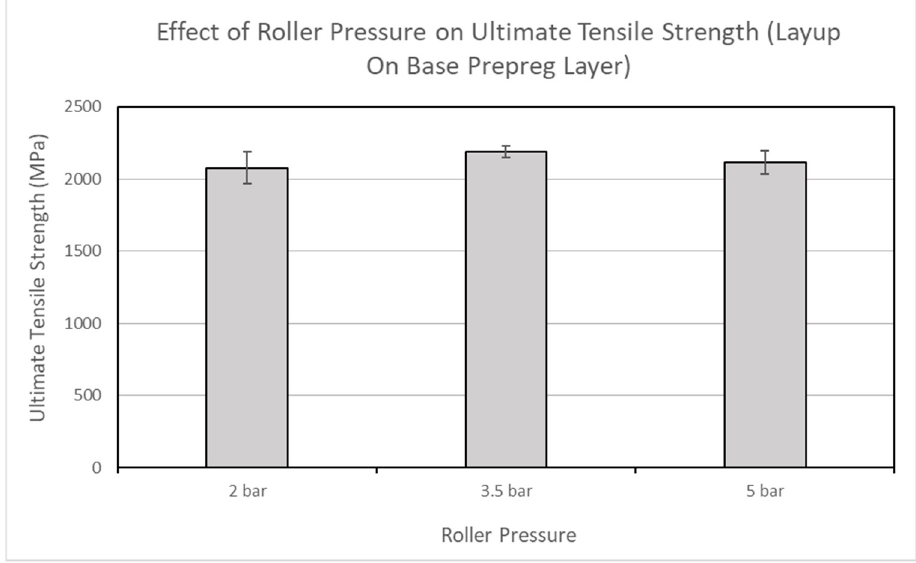
Figure 14. Effect of roller pressure and base layer on ultimate tensile strength for layups on prepreg base layer.